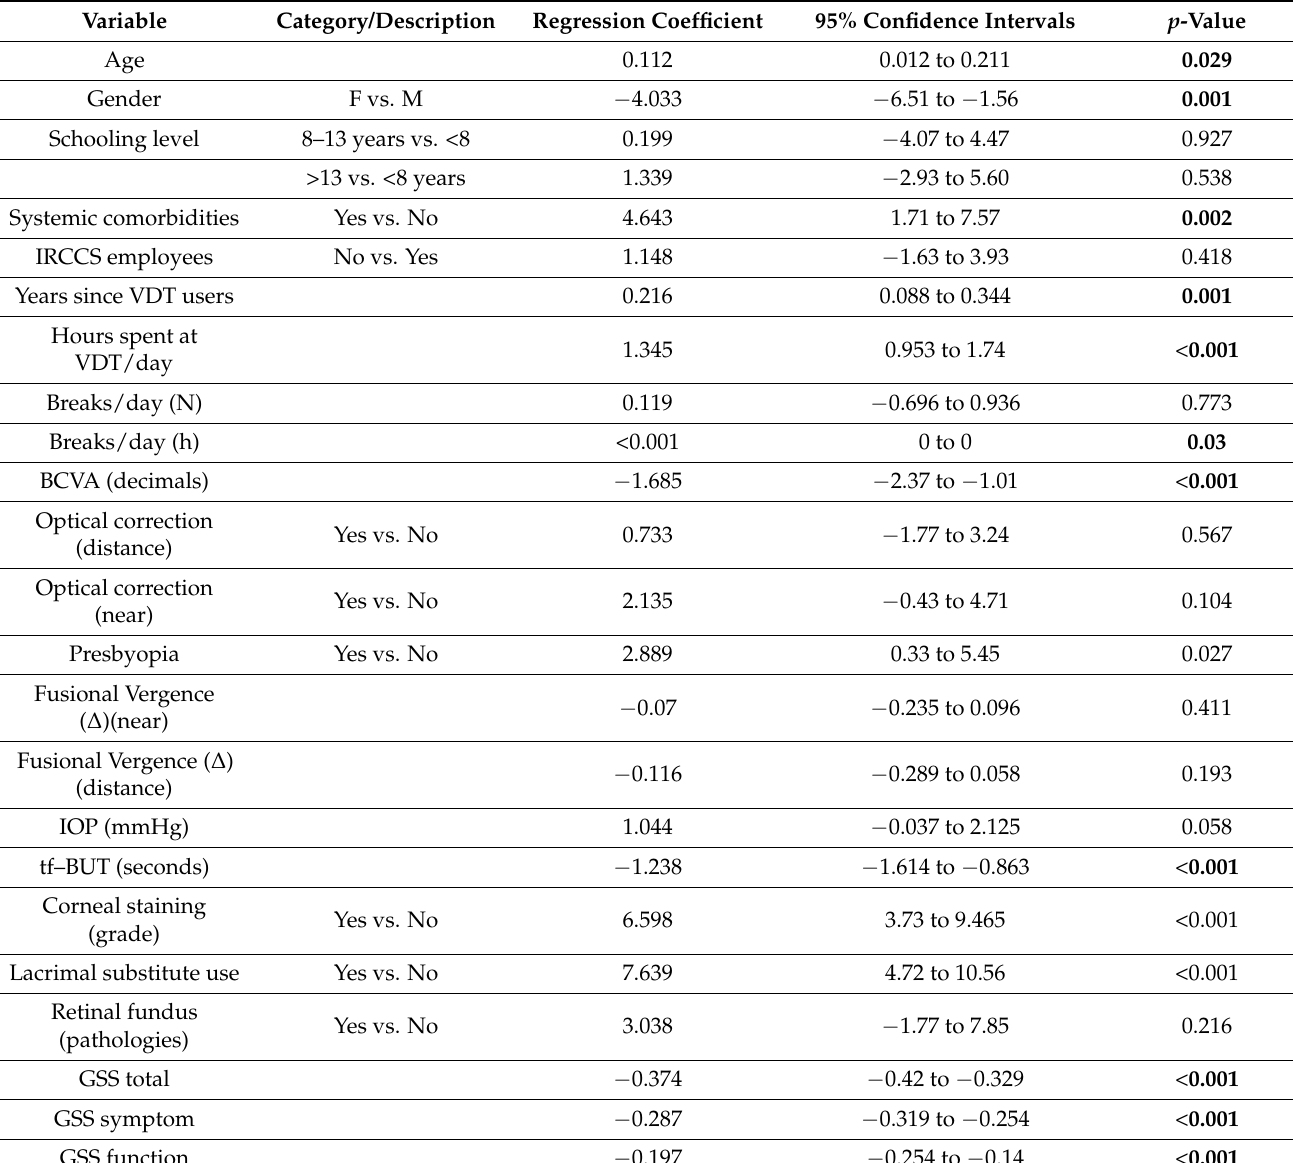
Table 4. Validity of the CVSS17: association between CVSS17 score and patients’ characteristics (univariable linear regression models) (F = female; M = male; VDT = video terminal workers; N = number; h = hours; ∆ = diopters; tf-BUT = tear film break-up time; IOP = intraocular pressure; GSS = Glaucoma Symptom Scale; (bold font: statistically significant p